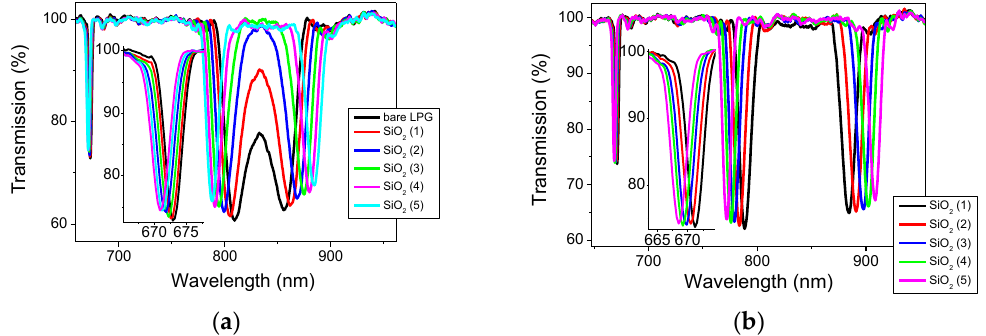
Figure 5. Transmission spectra of LPG with period of 110.9 µm: ( a ) taken in air before ( black ) and after the deposition of 1st ( red ), 2nd ( blue ), 3rd ( green ), 4th (magenta) and 5th layer of silica nanoparticles (cyan) and ( b ) taken in solution after the deposition of 1st (black), 2nd ( red ), 3rd ( blue ), 4th ( green ) and 5th layer of silica nanoparticles.